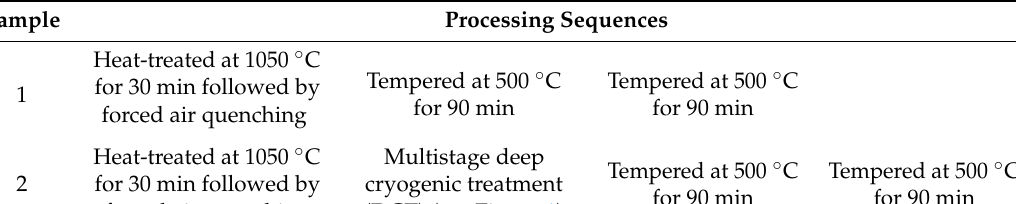
Table 2. Different heat treatment processes applied to the AISI A8 tool steel samples.